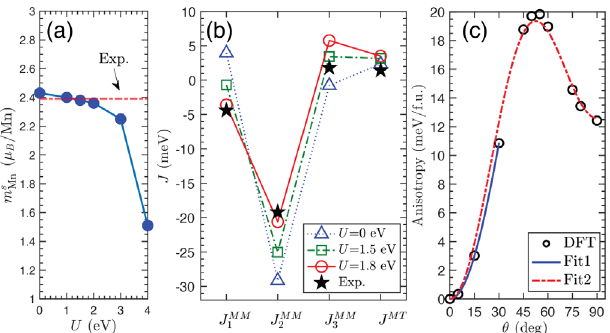
FIG. 8. Intrinsic magnetic properties calculated in Tb166 and compared to the experimental values. (a) On-site Mn spin magnetic moment m s and (b) interlayer exchange parameters Mn as functions of Hubbard U applied on Mn- 3 d states. Hubbard U on Mn 3 d is included using the around-the-mean-field double- counting scheme in DFT þ U . (c) Variation of energy as a function of spin-quantization axis rotation. θ ¼ 0 ° corresponds to the out-of-plane spin orientation parallel to the c axis. Fit1 and Fit2 correspond to fittings to the expressions of E ð θ Þ ¼ K 1 sin 2 θ near θ ¼ 0 and E ð θ Þ ¼ K 1 sin 2 θ þ K 2 sin 4 θ over the full θ range,